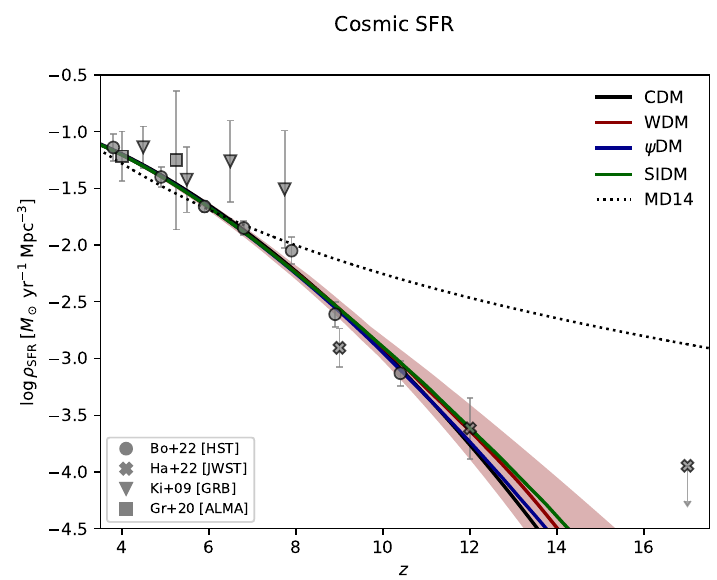
Figure 7. The cosmic SFR density as a function of redshift. Data are from UV-HST (circles; [77,78]), UV- JWST (crosses; [80]), GRB-Fermi (inverse triangles; [100]), and (sub)mm-ALMA (squares; [101]). Lines illustrate the best fits from the MCMC analysis in various DM scenarios: CDM (black), WDM (red), ψ DM (blue), and SIDM (green). The typical 2 σ credible interval from the sampling of the posterior distribution is shown, for clarity, only in the WDM scenario, as a red shaded area. For reference, the dotted line is the classic fitting formula gauged at z (cid:46) 6 by